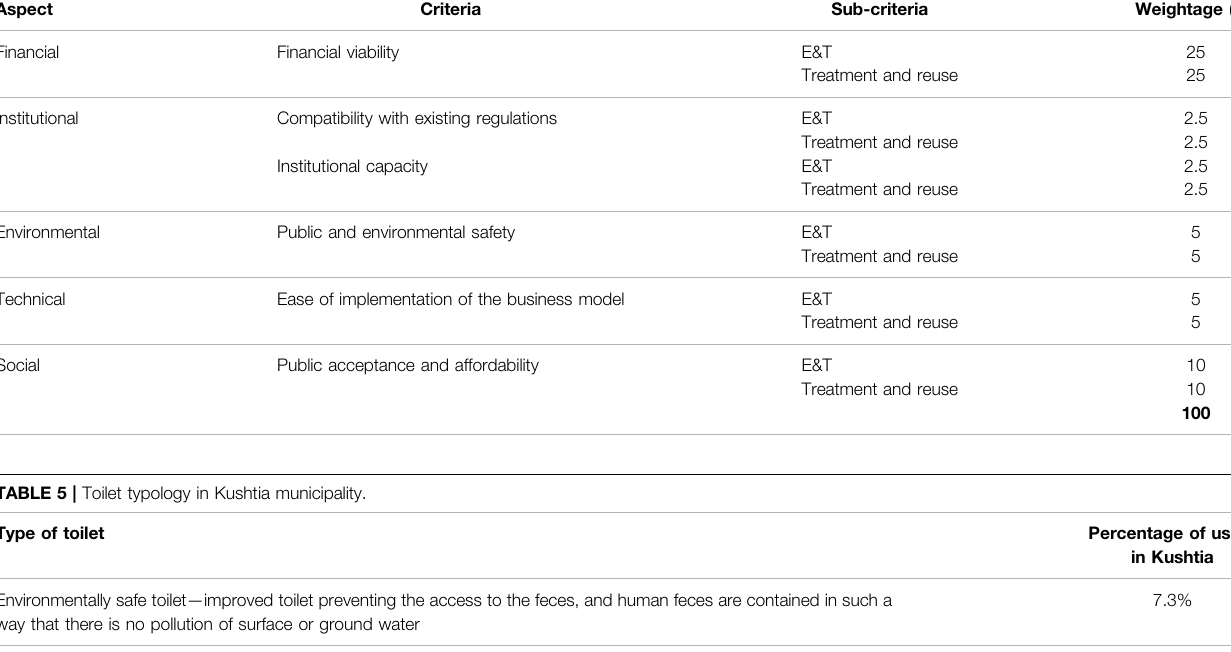
TABLE 4 | Criteria and weightage for multi-criteria analysis. Bold value is the total (sum) of values of the column i.e. weightage of each aspect totaling to 100%.